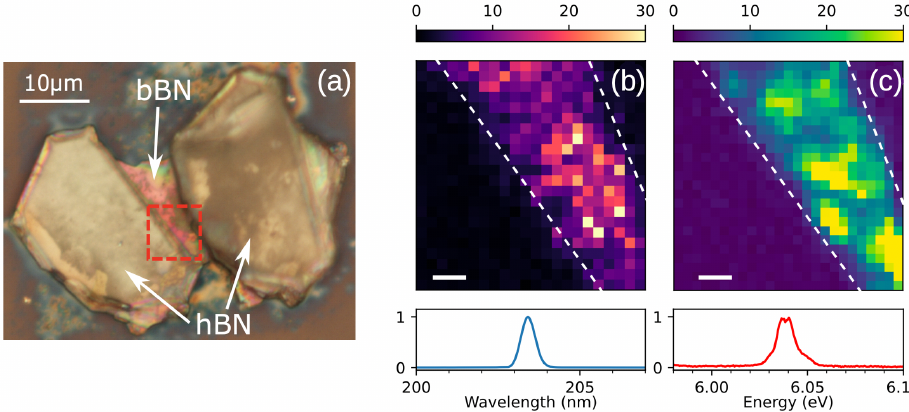
Figure 12. ( a ) Photograph of an exfoliated sample composed of a bBN region sandwiched be- tween two hBN regions. ( b ) Mapping of the PL emission from the square area indicated in ( a ). ( c ) Mapping of the SHG emission. After